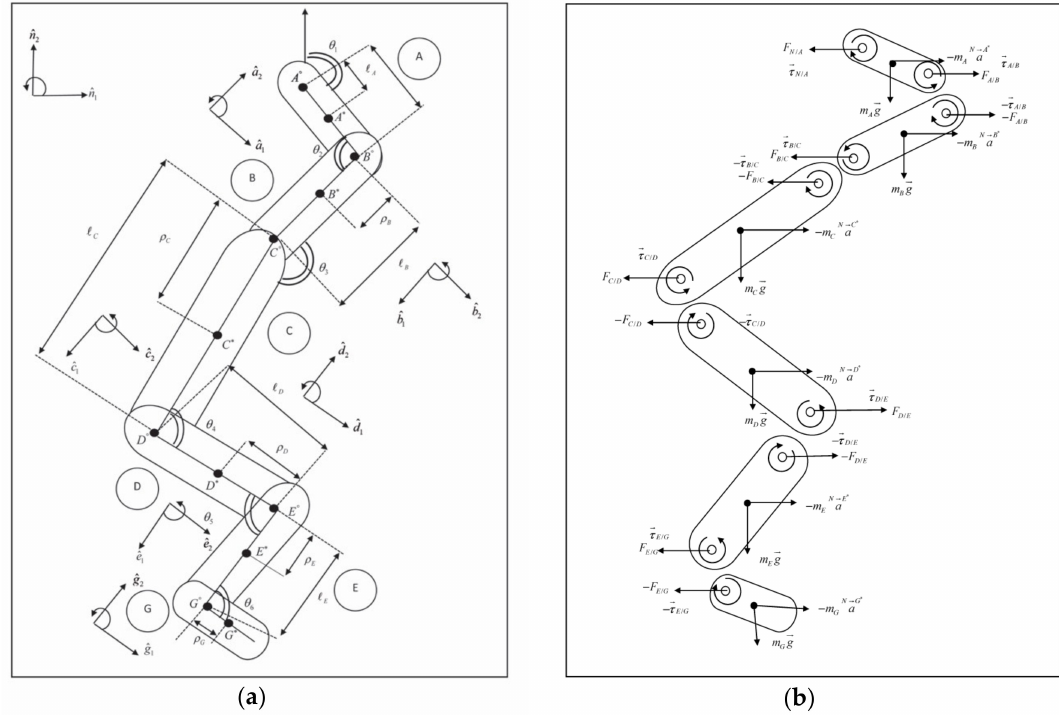
Figure 4. ( a ) Two-link kinematics open-chain representing the whole body in the sagittal plane. ( b ) A free-body diagram that shows force acting at every body